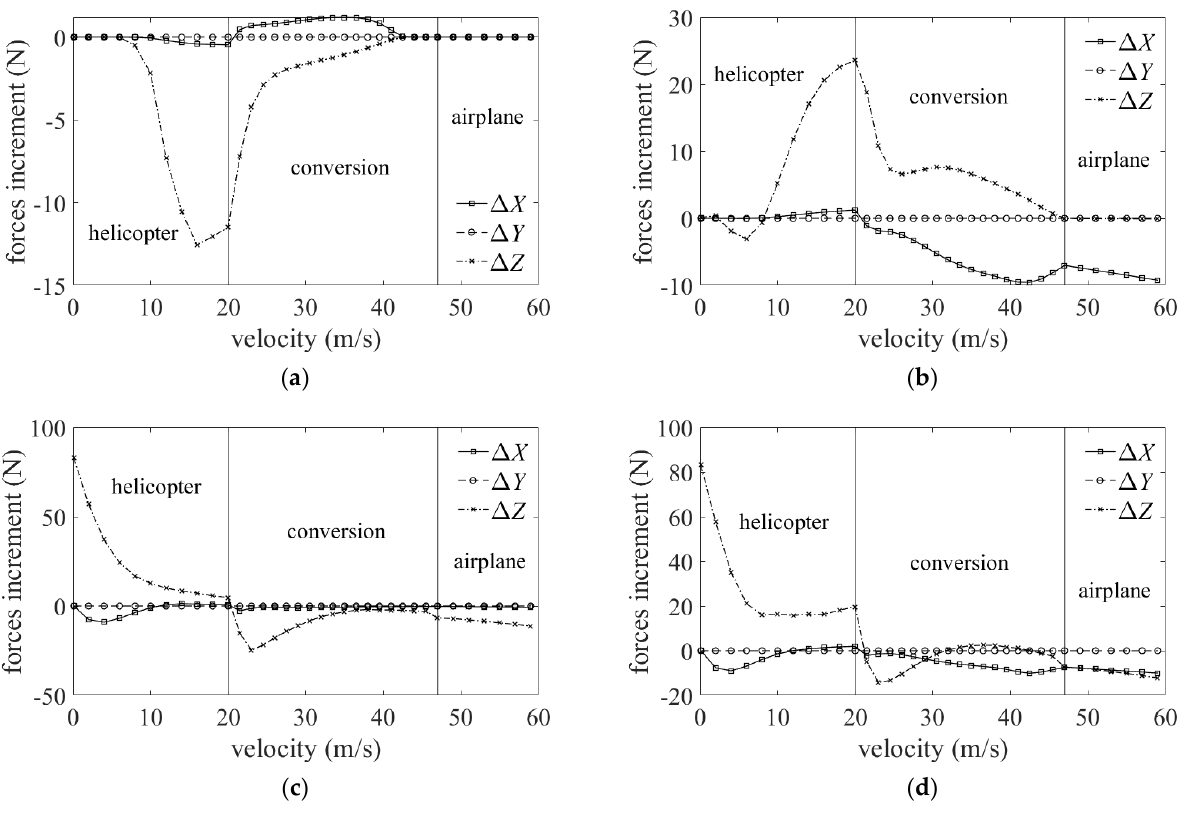
Figure 12. Influence on body forces with different interaction. ( a ) Body forces increment caused by rotor – lateral interaction. ( b ) Body forces increment caused by rotor – longitudinal interaction. ( c ) Body forces increment caused by rotor – wing interaction. ( d ) Body forces increment caused by total interaction. where Δ X , Δ Y , Δ Z represent the body forces increment along body axis.